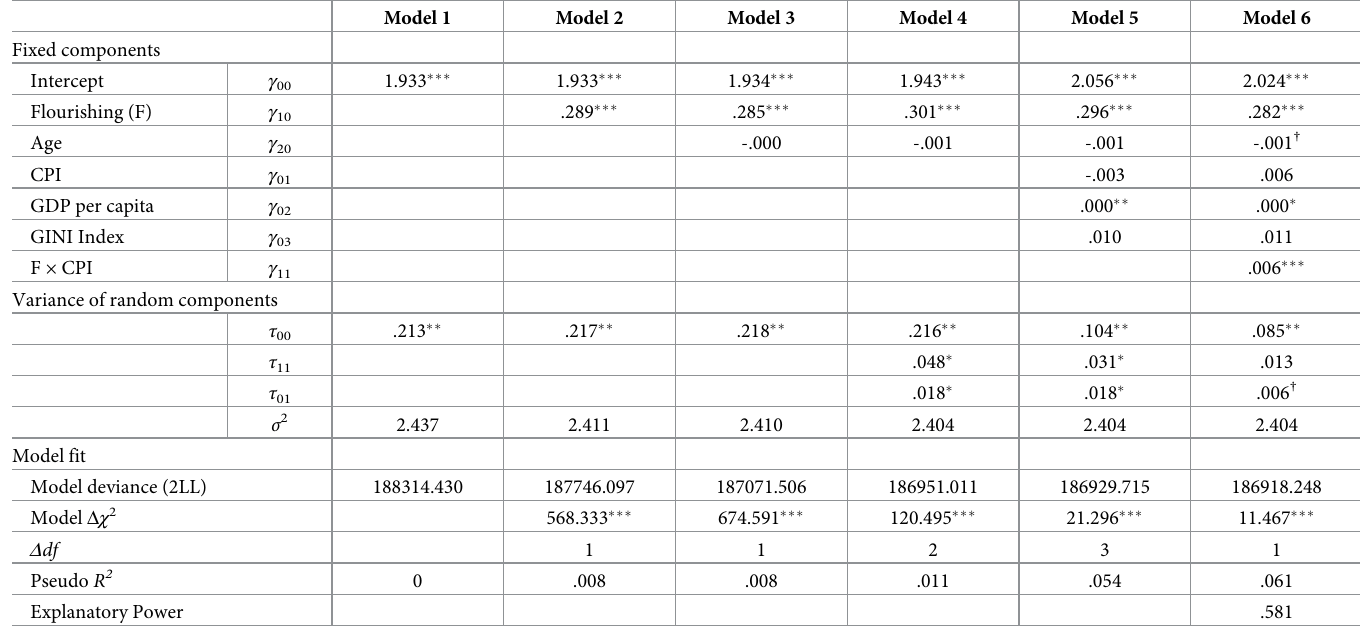
Table 5. Parameter estimates for the six models examining the relation of charitable activities on flourishing and CPI in Study